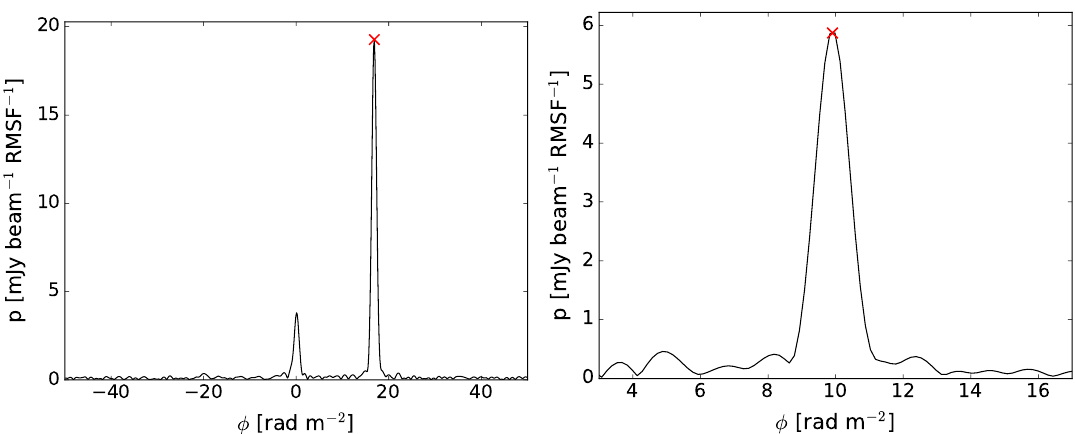
Figure 5. Examples of the absolute value of the FDF for the polarised hotspots of two FRII radio galaxies. ( Left panel ) FDF for the southwest hotspot of ILT J105715.33+484108.6 (Figure 4, top left), with the red cross indicating the real polarised peak of ∼ 19.3 mJy beam − 1 at a Faraday depth of ∼ 16.85 radm − 2 . The other peak in the FDF near 0 radm − 2 is due to instrumental polarisation at a level of ∼ 2% of Stokes I ; ( right panel ) FDF of the south hotspot of ILT J134102.90+491609.1 (Figure 4, top right), with a peak of ∼ 5.9 mJy beam − 1 at a Faraday depth of ∼ 9.9 radm − 2 .